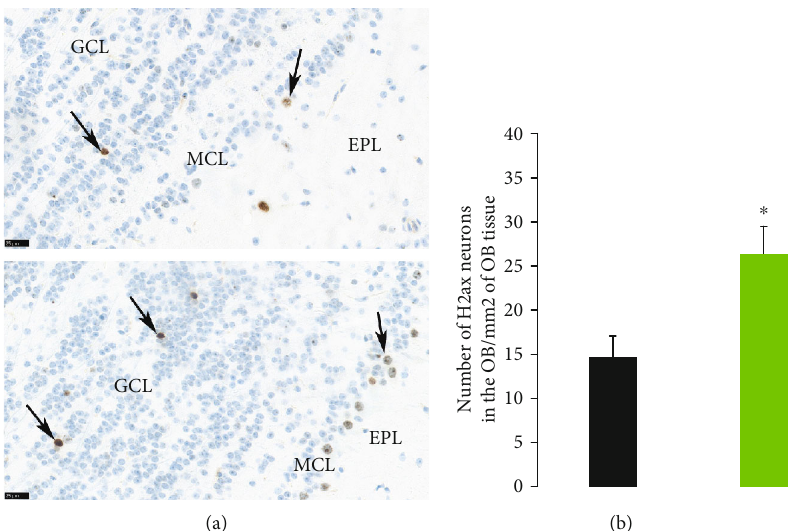
Figure 1: (a) Histological overview of the olfactory bulbs (OB) from 1 young mouse (top panel) and old mouse (bottom panel) stained for H2AX and taken at same magni fi cation ( scale bar = 25 microns ). The OB of the old mouse exhibited signi fi cant increase in the numbers of H2AX-positive neurons particularly in the mitral cell layer (MCL) and the granular cell layer (GCL). H2AX-positive neurons are depicted by arrows. EPL: external plexiform layer. (b) Numbers of H2AX neurons in the olfactory bulbs of young and aged mice/mm 2 of olfactory bulb tissue. Data are presented as mean values ± SEM for young (black, n = 4 ) and aged C57BL/6 mice (green, n = 4 ). Two-sample t